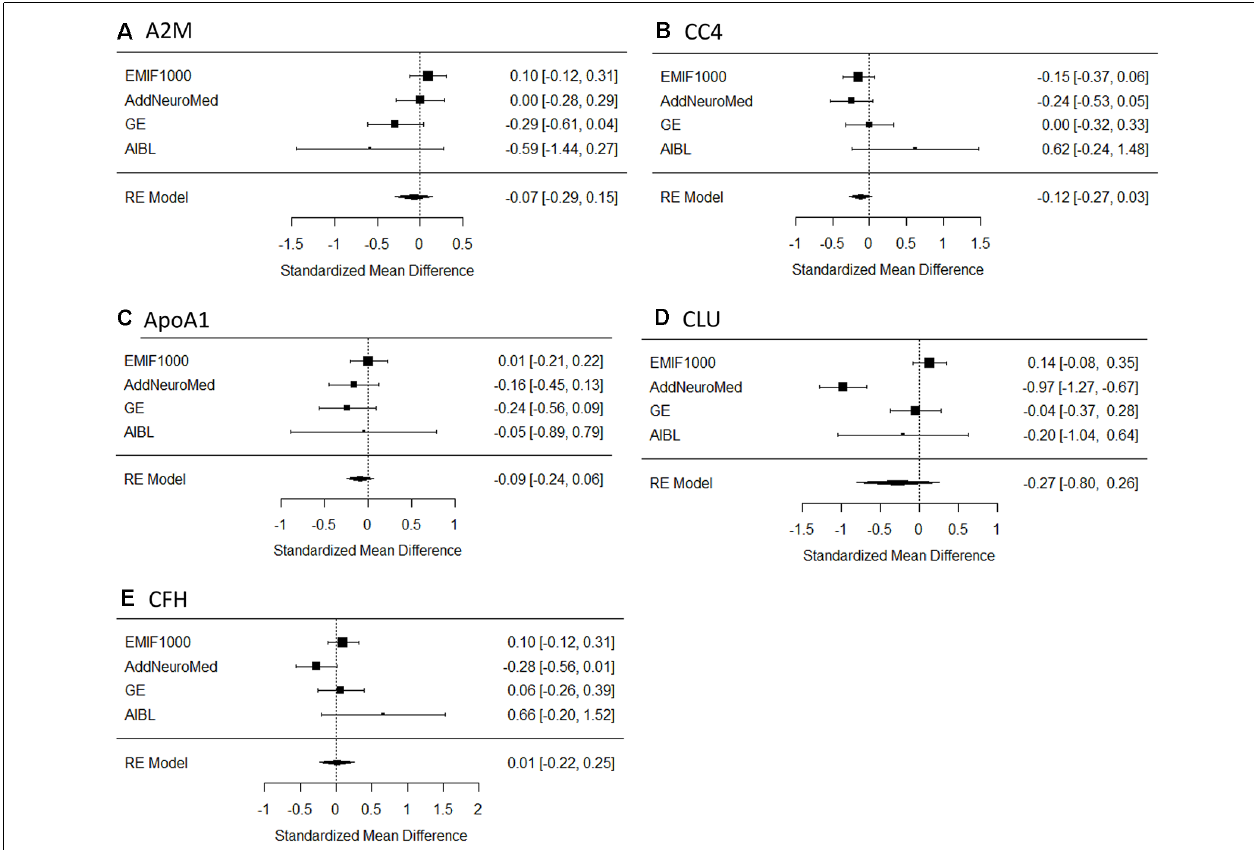
FIGURE 3 | Forest plot of five proteins between MCIc and MCInc. MCI, mild cognitive impairment; MCIc, MCI converted to AD; MCInc, MCI non-converted to AD; RE, random effect; (A) A2M, alpha-2-macroglobulin; (B) CC4, complement component 4; (C) ApoA1, apolipoprotein A-I; (D) CLU, clusterin; (E) CFH, complement factor H; EMIF, European Medical Information Framework; AIBL, Australian Imaging, Biomarkers and Lifestyle Flagship Study of